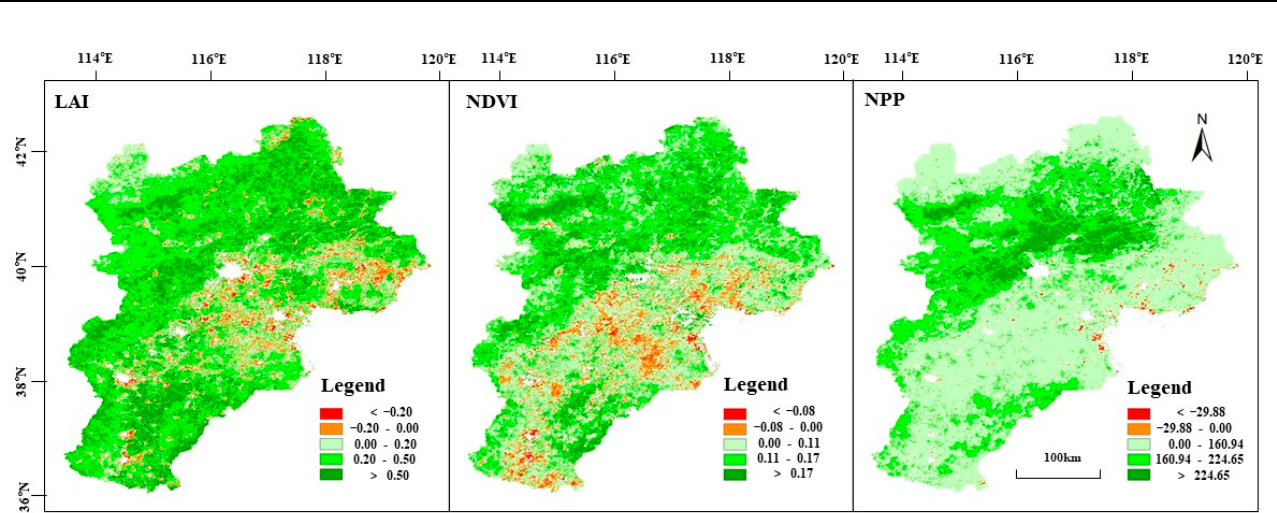
Figure 8. Spatial variation in Beijing–Tianjin–Hebei ecological parameters from 2001 to 2020. The regional averages of the four indices in Beijing sequentially decreased by forest- shrubland, grassland and cropland, indicating that cropland contributed the least to the overall ecosystem. In Tianjin, cropland contributes most to the whole region, because the regional average values are between cropland and the other three types. The regional av- erage value is close to that of cropland, showing that Hebei’s ecological system is mainly determined by cropland, though the other three vegetation types have a positive influence on the regional value.